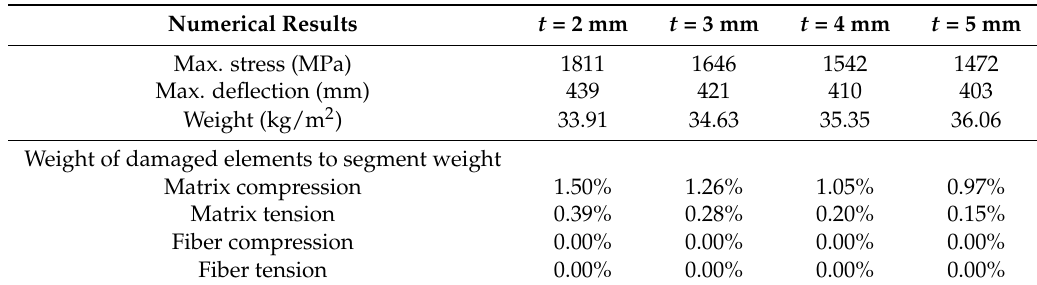
Table 4. Parameter study for the laminate thickness of the span-ribs.